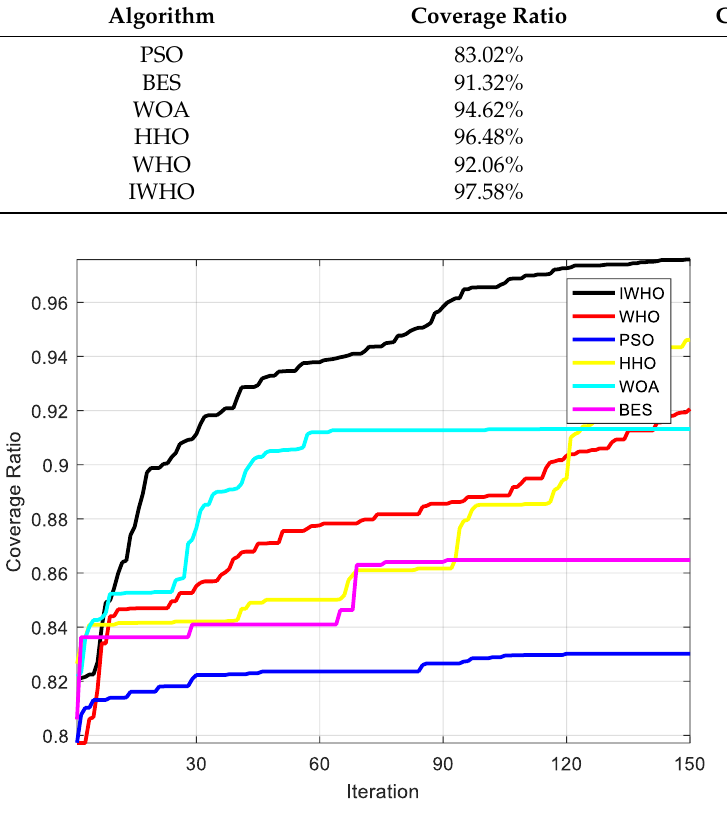
Figure 7. Comparison of coverage convergence curves. Table 9. Comparison of experimental results from various algorithms.